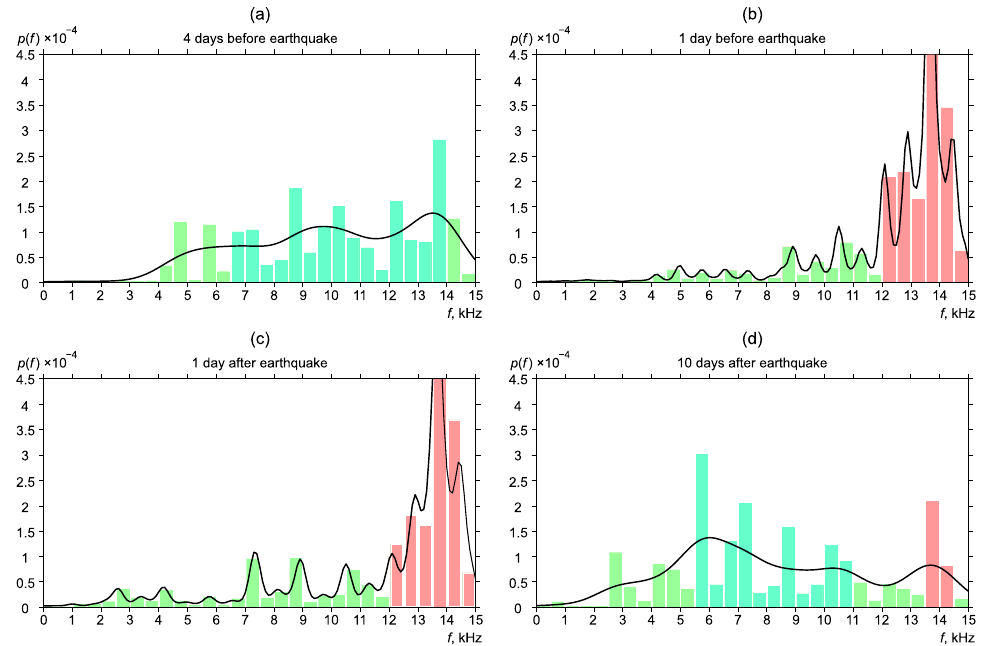
Figure 10. Dynamics of the probability density of distribution of the most powerful frequencies of geoacoustic pulses before and after the earthquake No.